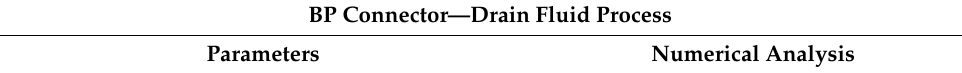
Table 4. Flow, pressure, and vorticity numerical analysis for BP connector— fluid draining process.